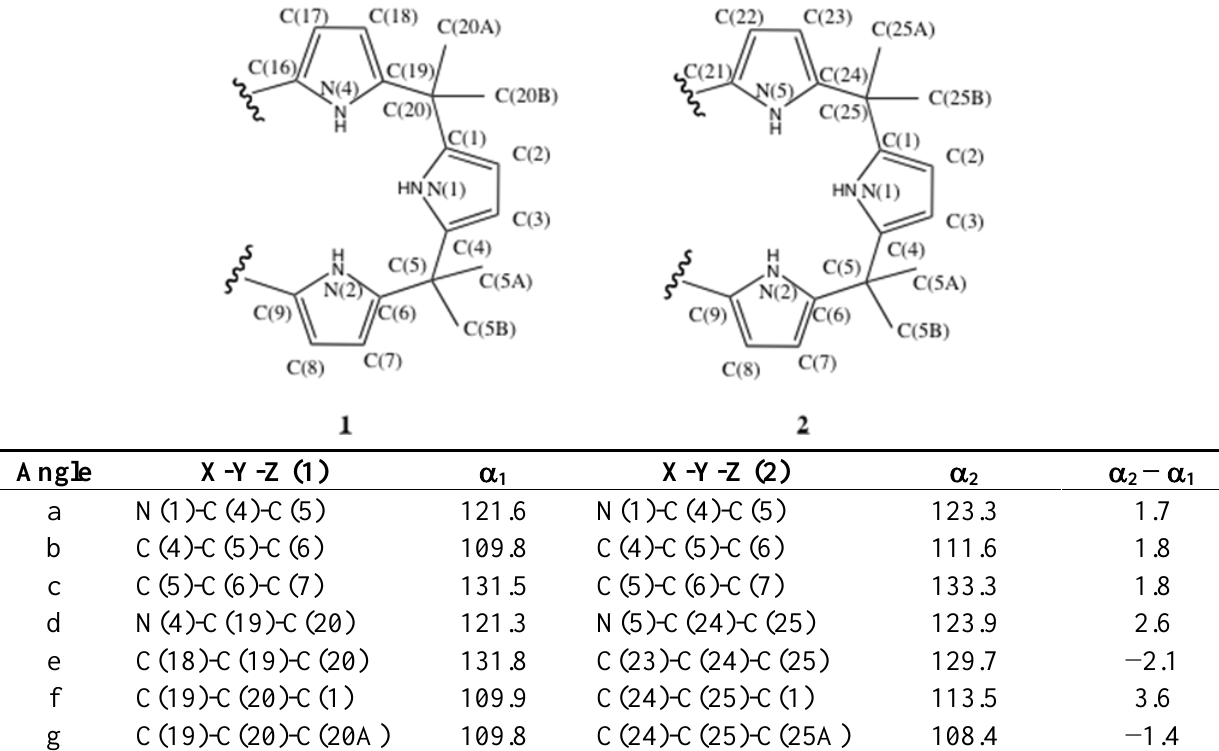
Table 1. Representative bond angles in 1 and 2 from the X-ray diffraction data